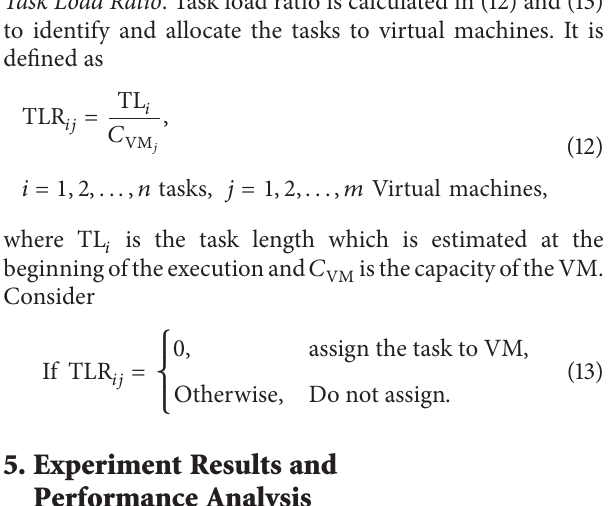
Figure 5: Execution completion time (time